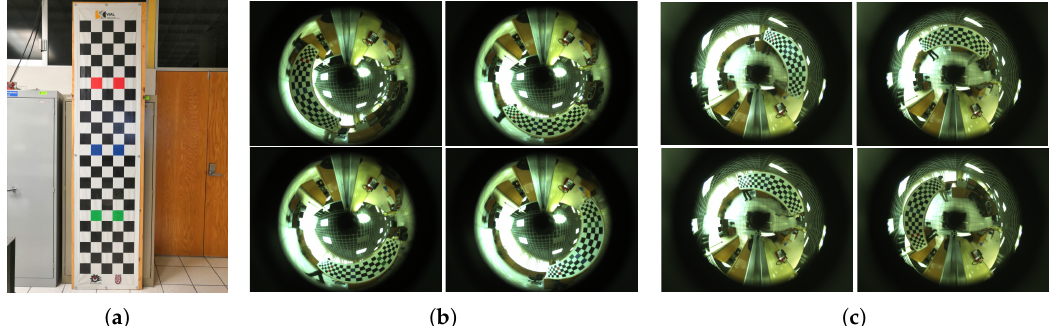
Figure 2. Calibration pattern. ( a ) Chessboard pattern ( b ) Images of the pattern using the upper camera. ( c ) Images of the pattern using the lower